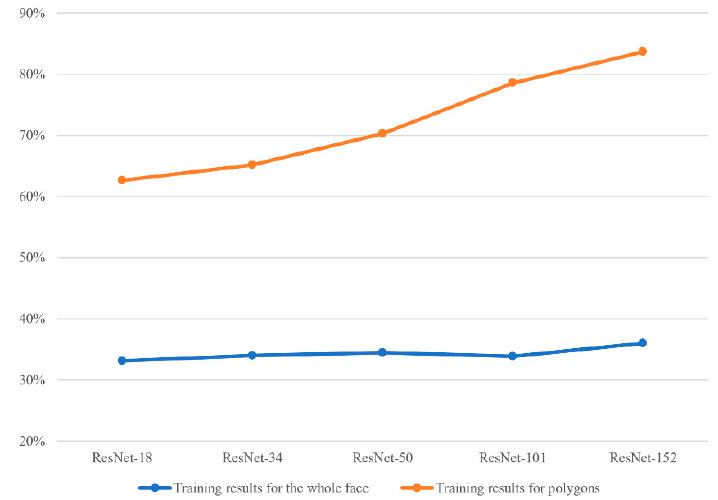
Figure 16. Average accuracy results (from K-fold cross validation), comparing training with the